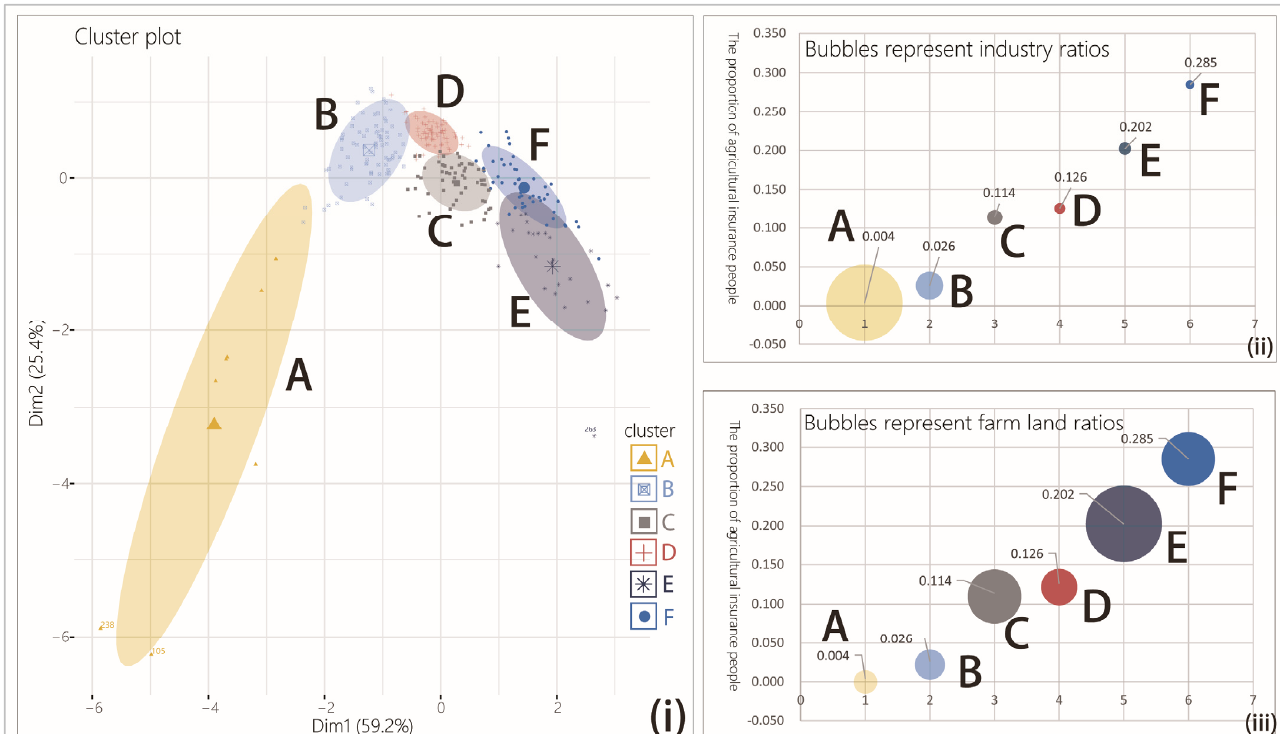
Figure 2. Classification of the probability distribution of LTFAs—scattered fuzzy C-means graph. Note: The numbers indicate the corresponding LTFAs. The circle size indicates the probability of belonging to the Cluster i ( i represents A, B, C, D, E, F); the larger the circle, the higher the probability of belonging to the cluster. The color represents the probability of belonging to the cluster; the darker the color, the stronger the probability. The numbers corresponding to the bubbles in two right panels are the agricultural population ratios. Source: results obtained in this study from